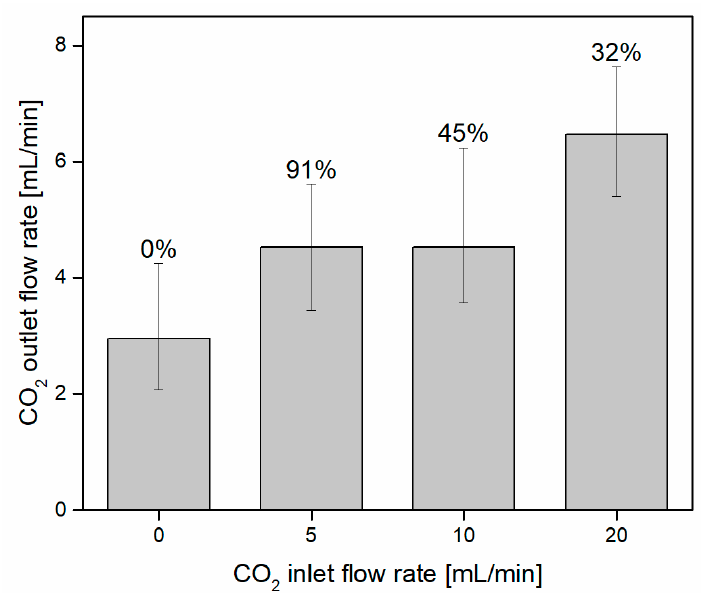
Figure 4. Average CO 2 flow for different pure CO 2 inlet flow rates (experimental conditions: J = 100 mA/cm 2 , Q pump = 1 mL/min, CO 2 /N 2 ratio = 100%/0%). The values on top of the columns represent the percentage of CO 2 captured with respect to that provided as input.